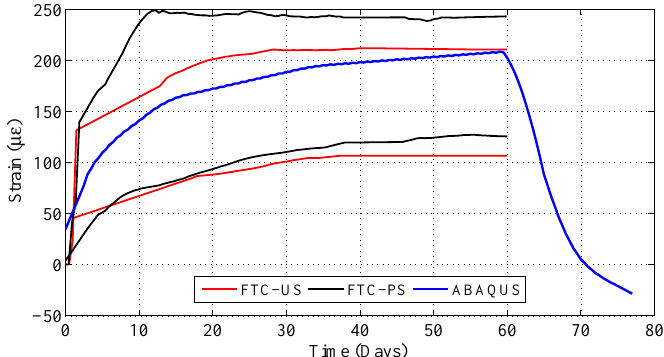
Figure 14. Comparison of FE simulation result with the experimental maximum strain envelope curves at the free-length of the strip. The simulation additionally provides information on the strain evolution after the cycles where the blocks are stored in the lab until lap-shear testing.